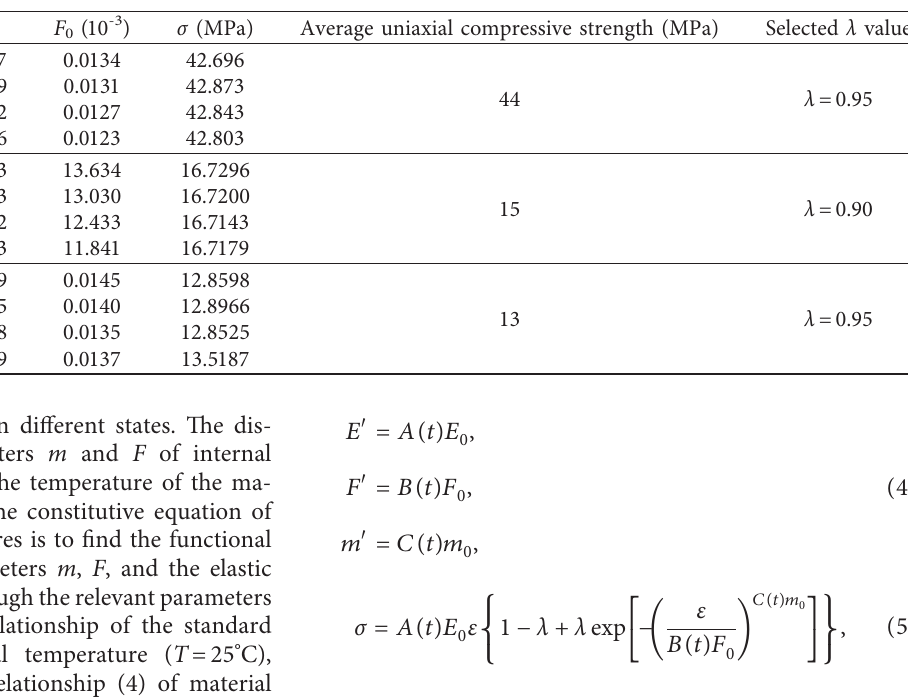
Figure 5: Changes of peak elastic modulus and peak stress of three types of rock masses with temperature under uniaxial compression. (a) The relationship between elastic modulus and temperature. (b) The relationship between peak stress and Table 1: m 0 and F 0 corresponding to different λ values.